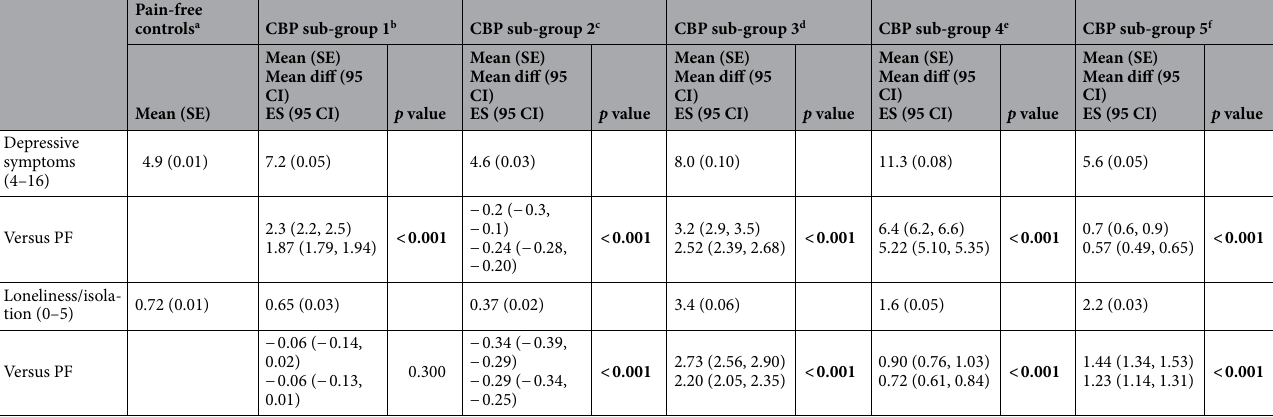
Pain-free controls a CBP sub-group 1 b CBP sub-group 2